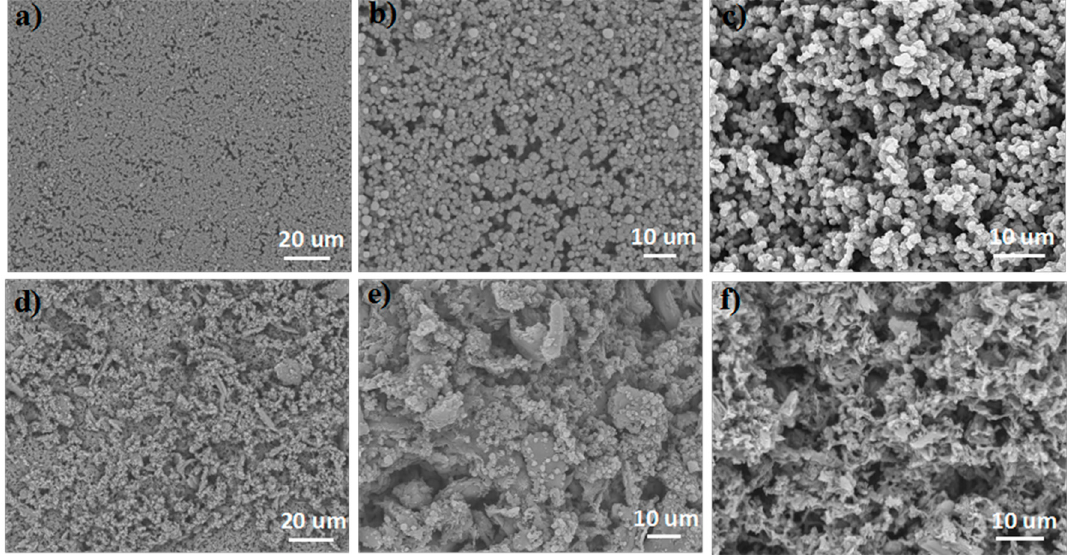
Figure 2 . SEM images of the top surface ( a , b ); cross sections of the pure nylon membrane ( c ) and the top surface ( d , e ); and cross section of the CSPNM ( f ).